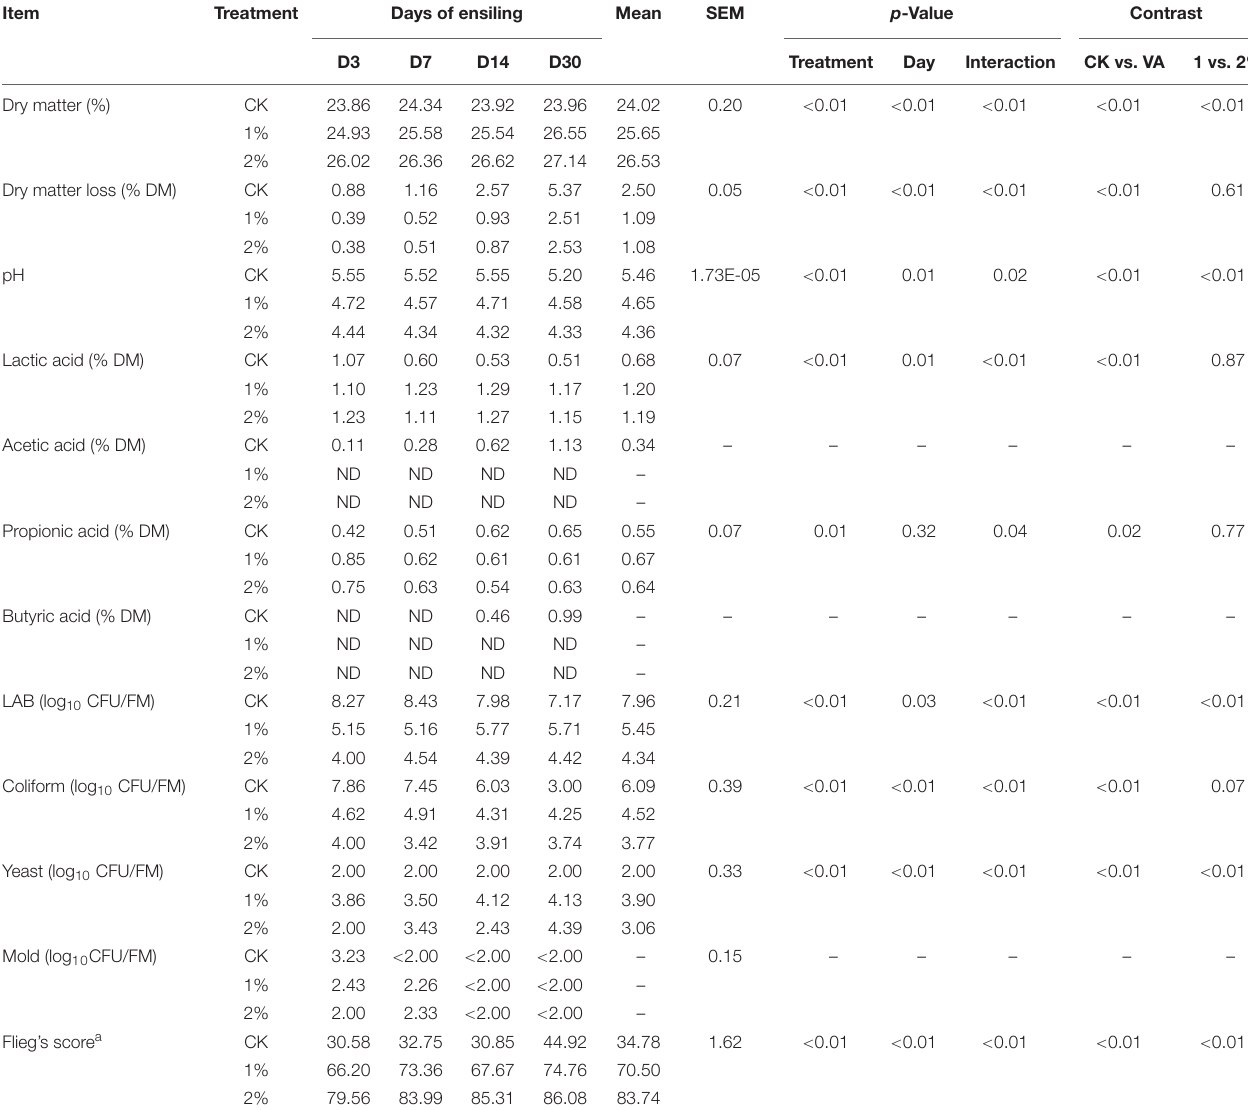
TABLE 1 | Effect of vanillic acid on dynamic fermentation parameters of stylo silage. Item Treatment Days of ensiling Mean SEM p -Value Contrast D30 Treatment Day Interaction CK vs.